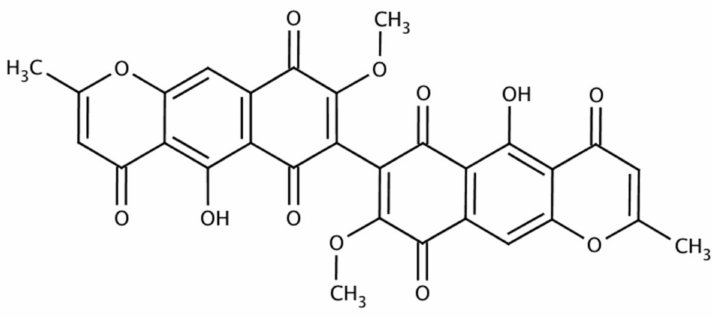
Figure 2. Structure of aurofusarin. Source: Glentham Life Sciences [33].